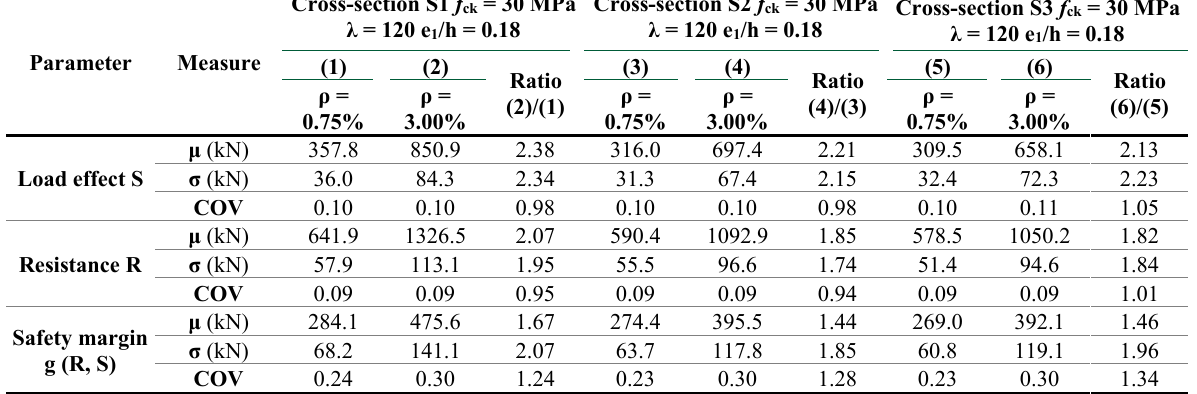
Table 5. Analysis of load effect, resistance, and safety